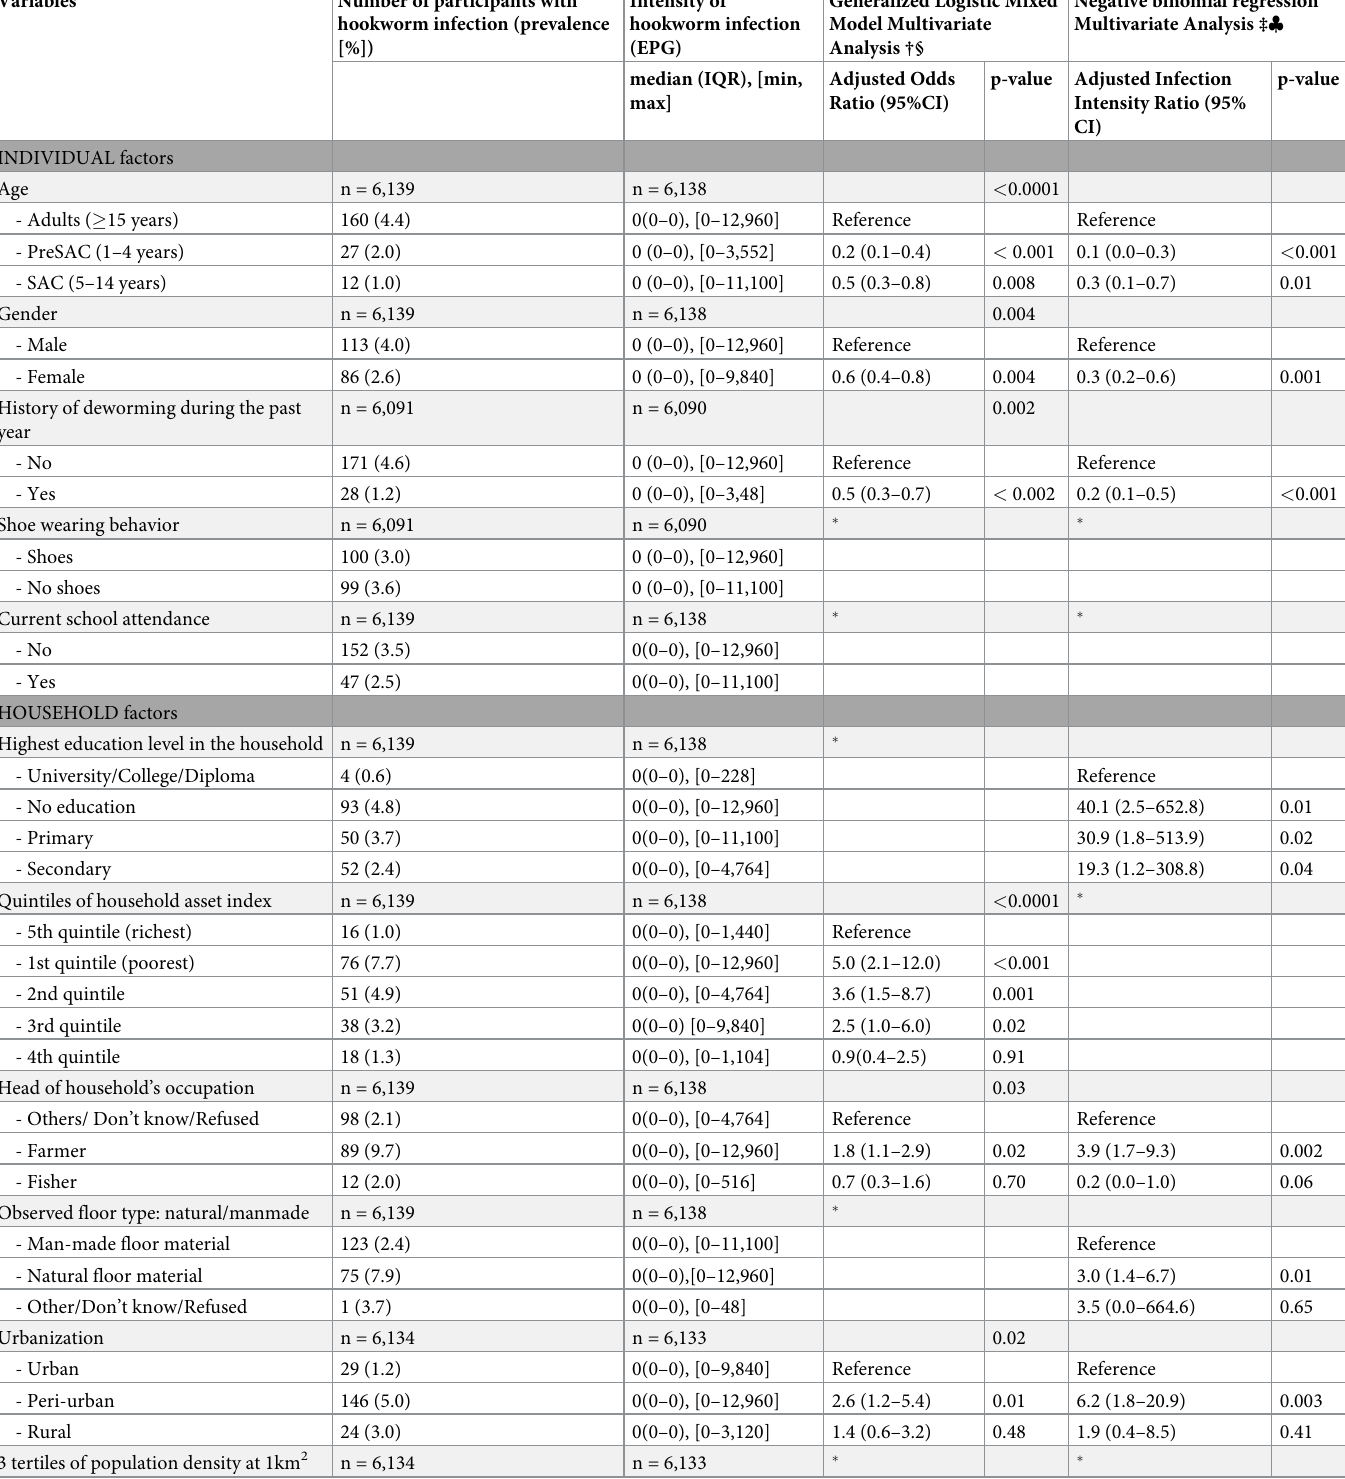
Table 3. Factors associated with the prevalence and the intensity of hookworm infection in Come´, Be´nin: findings from a cross-sectional baseline prevalence survey in the DeWorm3 STH–elimination